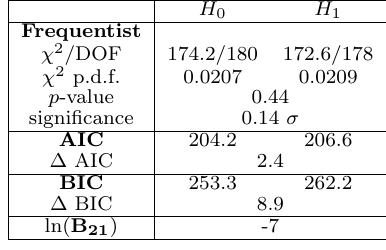
TABLE 5 Summary of model comparison results using frequentist, information theoretic, and Bayesian criterion for H 0 (background only) and H (background+cosine modulation with ω fixed.) According to the frequentist model comparison 1 test, the χ 2 p.d.f (which represents the likelihood of the model given the data) for H hypothesis is almost the same 1